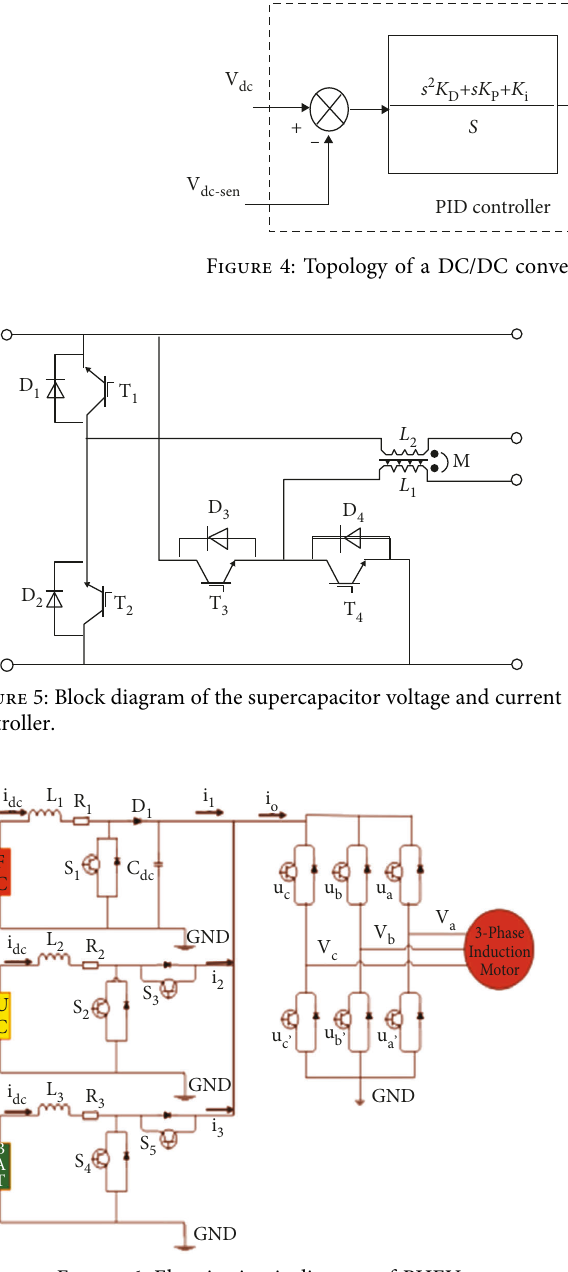
Figure 6: Electric circuit diagram of PHEV.